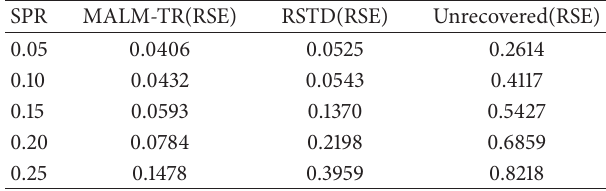
Figure 3: Tensor model of size 8 × 7 × 288. Table 3: Comparison of RSE on traffic data.